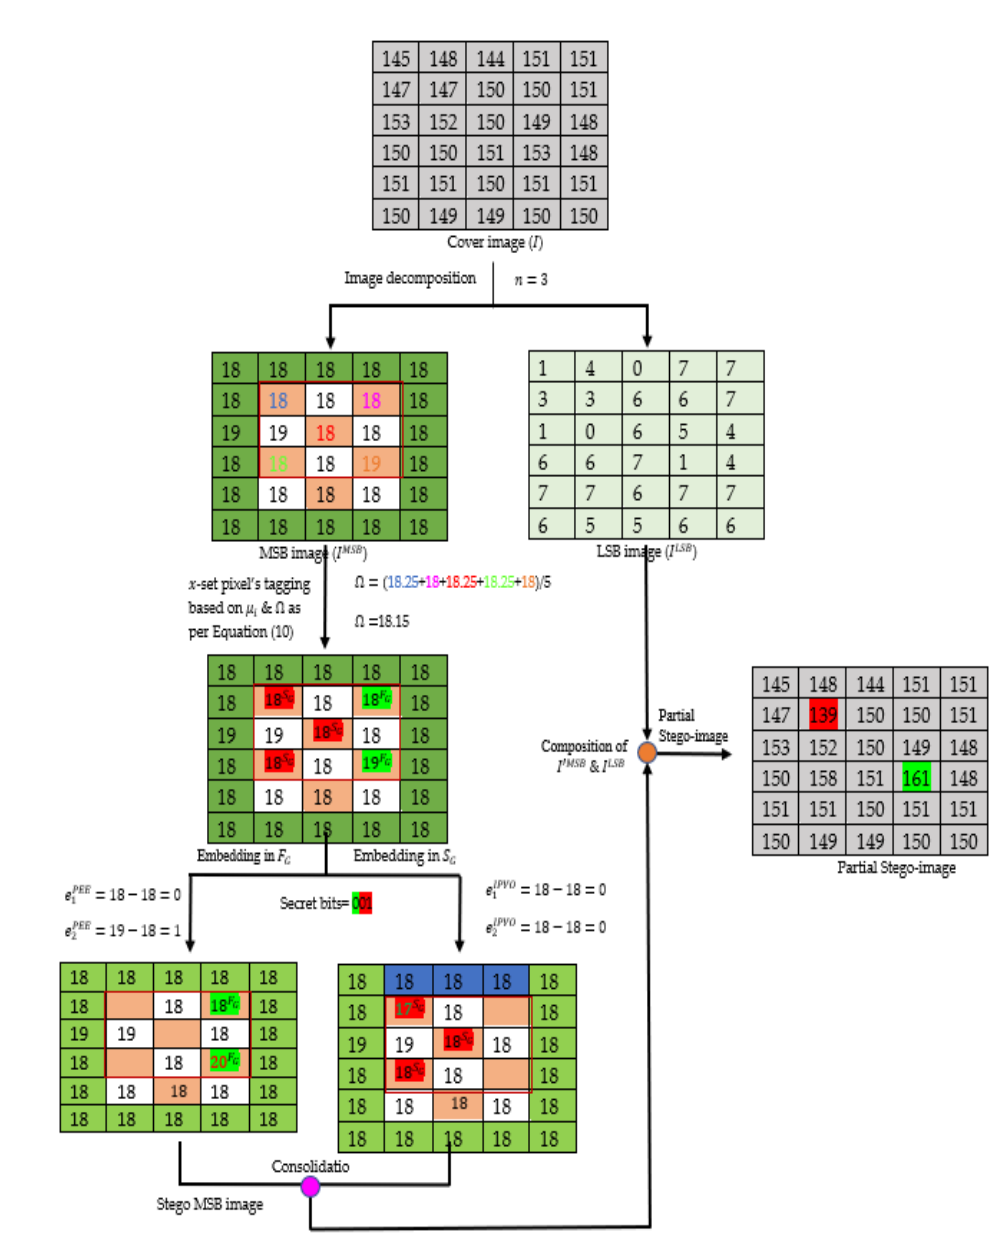
Figure 3. The proposed LM-RRDH embedding